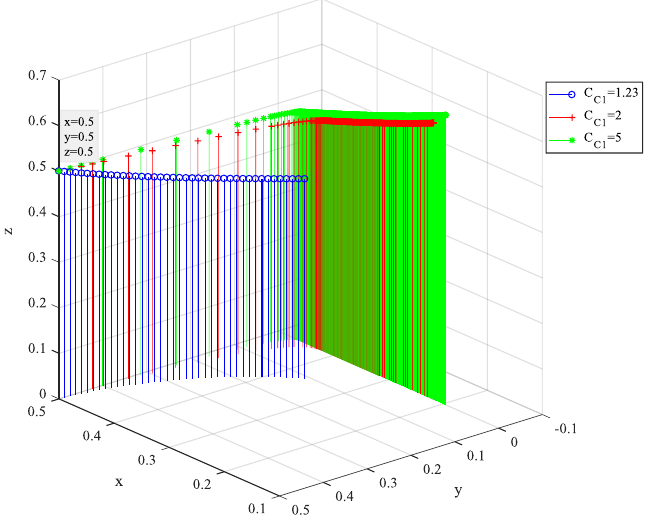
Figure 16. Behavior evolution of three players under different supervision cost C C 1 .